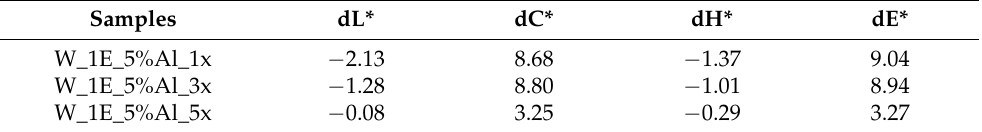
Table 17. Change in color coordinates of wool sample dyed with SJL aqueous extract with 5% Al mordants after 1st, 3rd and 5th washing cycle (compared with